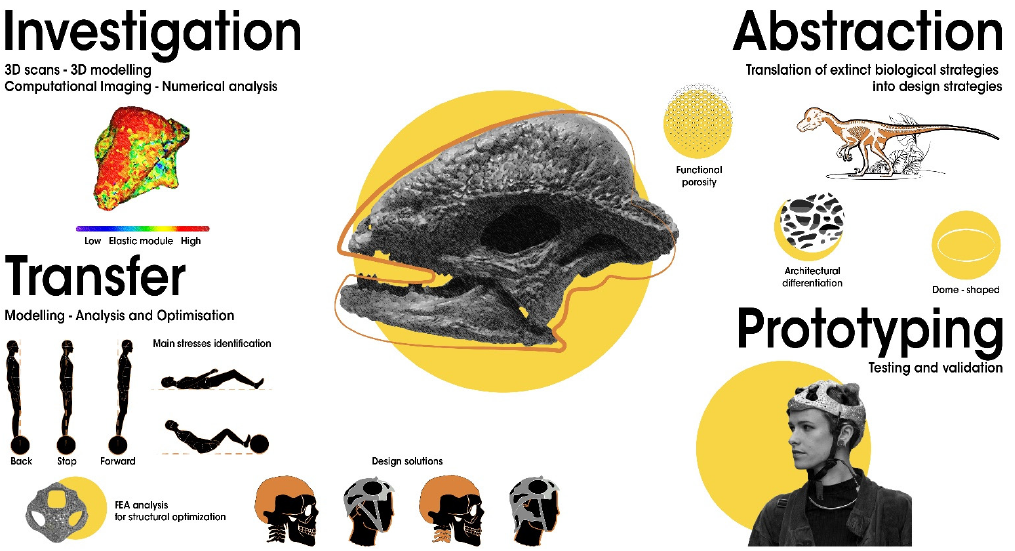
Figure 6. Paleomimetic process. A four-step bottom-up process of Paleomimetic solution transfer: from a fossil model to a technical application as exemplified by the Pachycephalosaurus -inspired helmet case study. (1) Extinct model identification and investigation: Stegoceras validum skull. (2) Abstraction of functional mechanisms in design principles: dome-shaped structure, architectural differentiation, and functional porosity determining lightness and resistance with energy-absorbing performances. (3) Transfer into models, analysis, and optimisation: 3D model of the helmet defining material, form, and structure; validation through numerical simulations identifying the principal stresses related to the final use; structural optimisation. (4) Prototyping, testing, and validation: prototype fabrication to be tested and validated. Design: Monica Bacelin. Research team: Carla Langella, Maddalena Mometti, Valentina Perricone, 2017. Graphical representation: Carmen Cerere. Image of the Stegoceras validum skull FEA analysis adapted from [111].